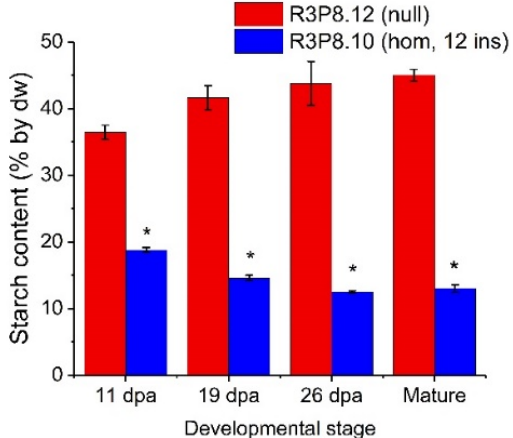
Figure 5. Starch content in endosperms of developing caryopses from field grown AsWRI1 -wheat (line R3P8.12, null; line R3P8.10, homozygous with 12 gene inserts) at 11-, 19-, and 26-days post anthesis (dpa) and at seed maturity. Starch content is given as percentage of dry weight (dw). Results are mean values of three replicates (i.e., plots) ± standard deviation. Bars marked with asterisks are significantly different to control (null) according to Fisher’s pairwise comparisons ( p < 0.05).